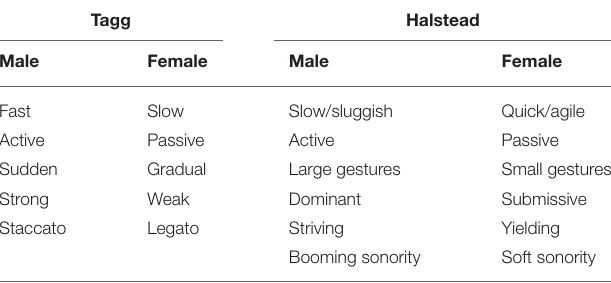
TABLE 5 | Corresponding properties reported by Tagg (1989) and Halstead